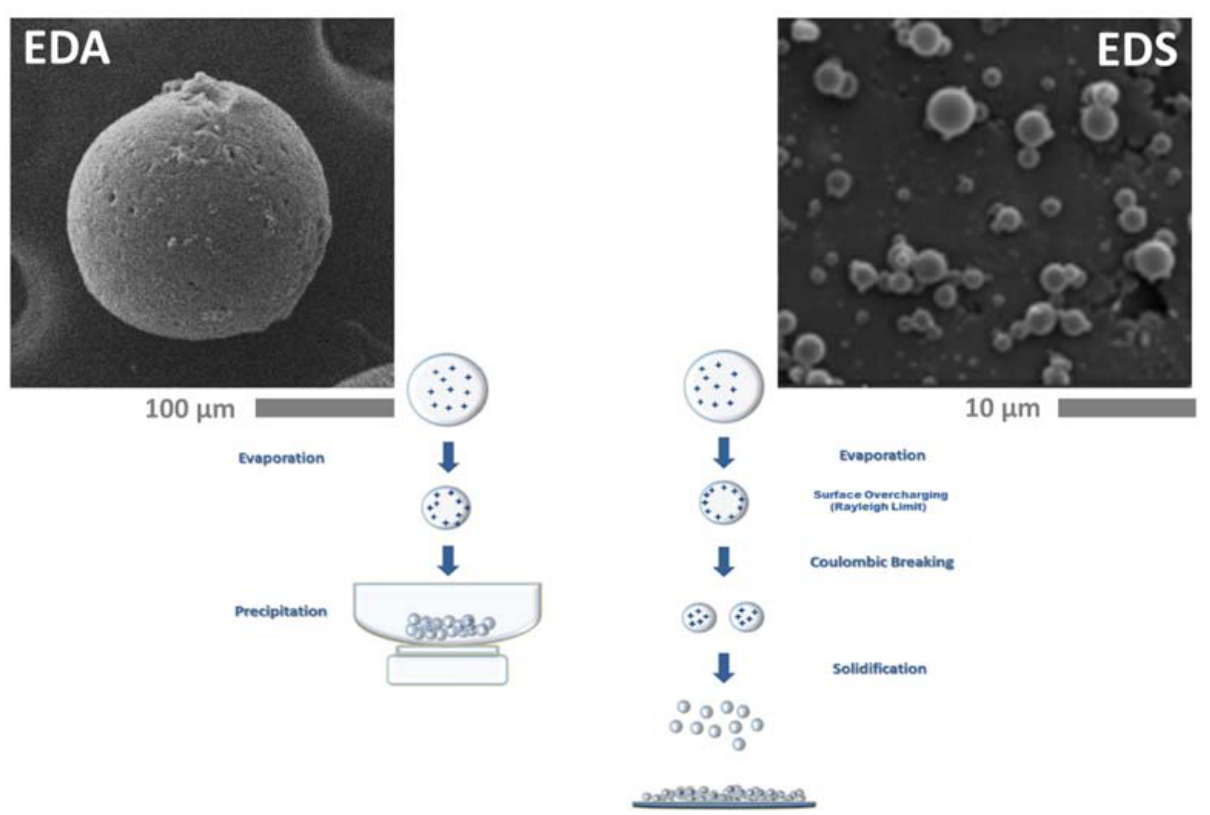
Figure 7. Representative scheme of electro fluid dynamics (EDT) processing modes: Electro Dynamic Spraying (EDS) vs. Electro Dynamic Atomization (EDA). Adapted from [98]. Copyright (2016), with permission from Elsevier.